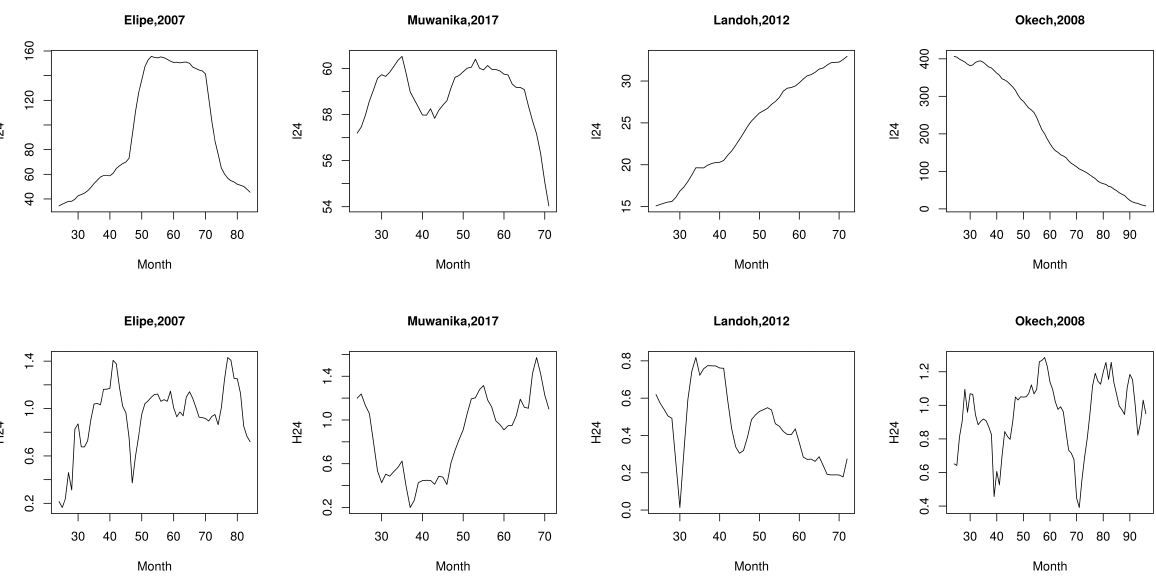
Figure A6. (Cont. Figure A5): Gomez-Elipe et al. (Karuzi in Burundi, 2007) [24], Muwanika et al. (Uganda, 2017) [26], Landoh et al. (Est Mono district in Togo, 2012) [25], and Okech et al. (Kenya, 2008) [27]. Figure A7. Comparative depiction of I 48 ( top ), H 48 ( middle ), S 48 ( bottom ) for (from left to right): Alhassan et al. (Kasena Nankana municipality in Ghana, 2017) [21], Appiah et al. (Ejisu-Juaben municipality in Ghana, 2015) [16], Bedane et al. (Kucha district in Ethiopia, 2016) [23], and Aregawi et al. (Ethiopia, 2014) [22].